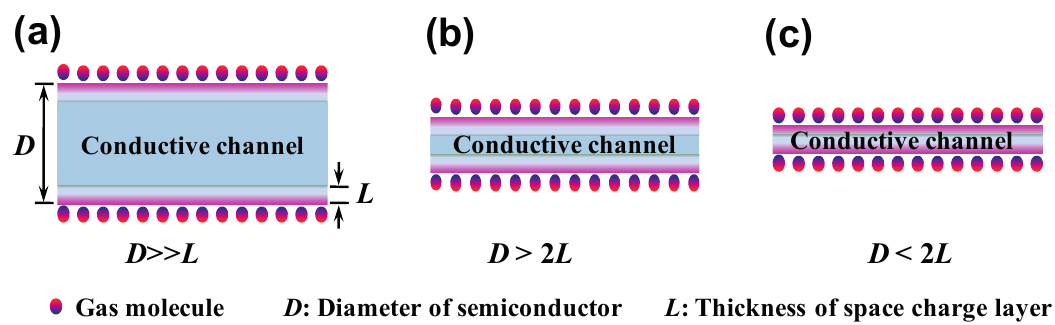
Figure 1. The relation between the thickness of semiconductor and the space charge layer for resistor sensor. ( a ) D >> L ; ( b ) D > 2 L ; ( c ) D < 2 L , D : the diameter of the semiconductor; L : the thickness of the space charge